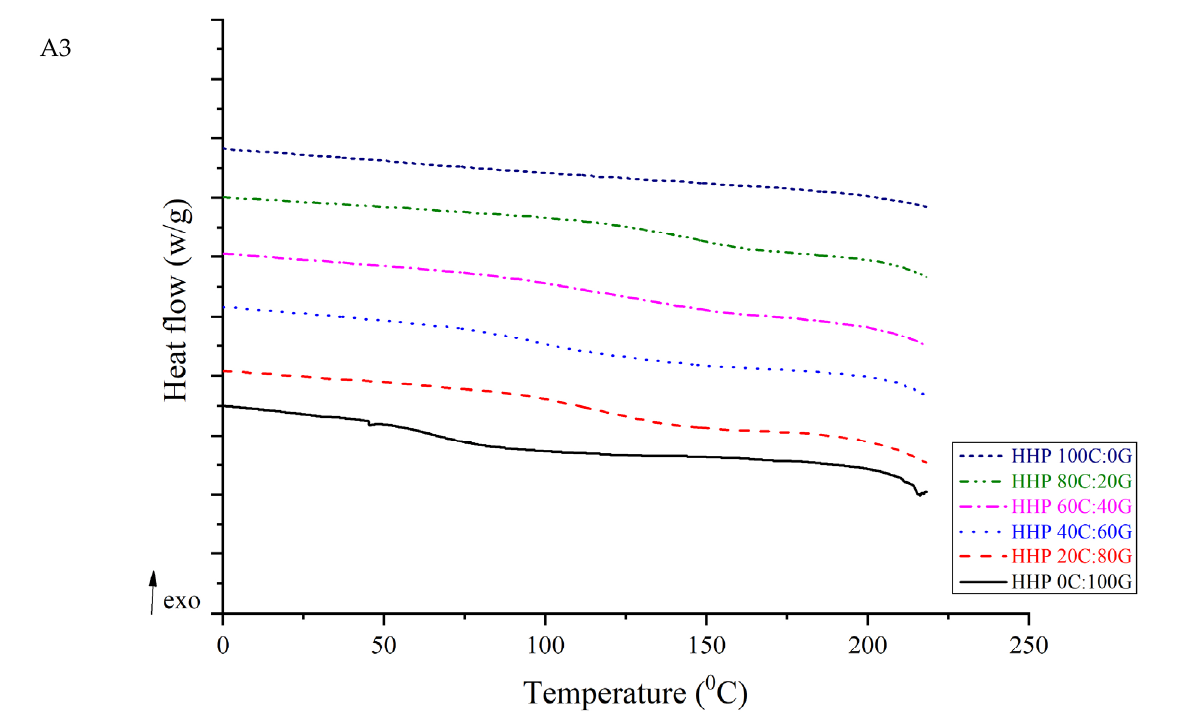
Figure 3. DSC curves of gelatin-based film incorporated with commercial chitosan ( A1 ), untreated chitosan ( A2 ), and HHP chitosan ( A3 ).